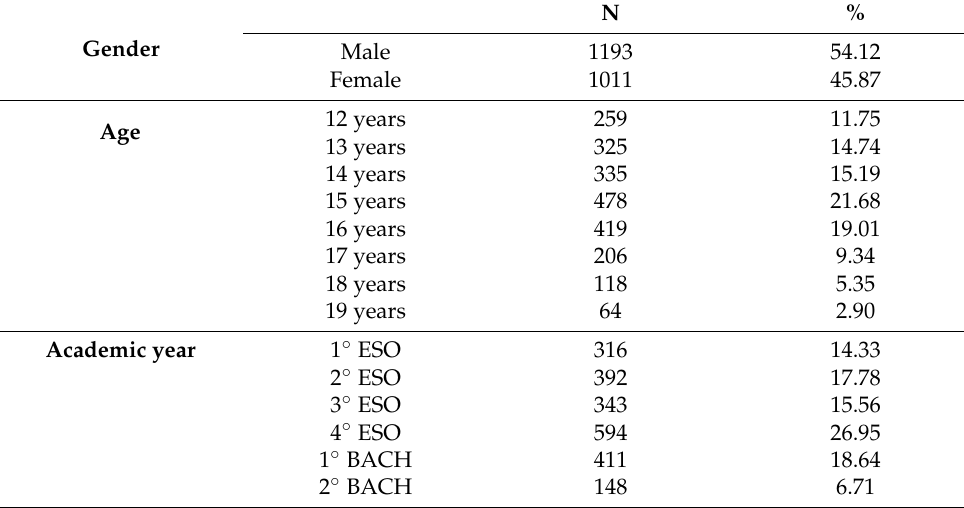
Table 1. Socio-demographic characteristics of the